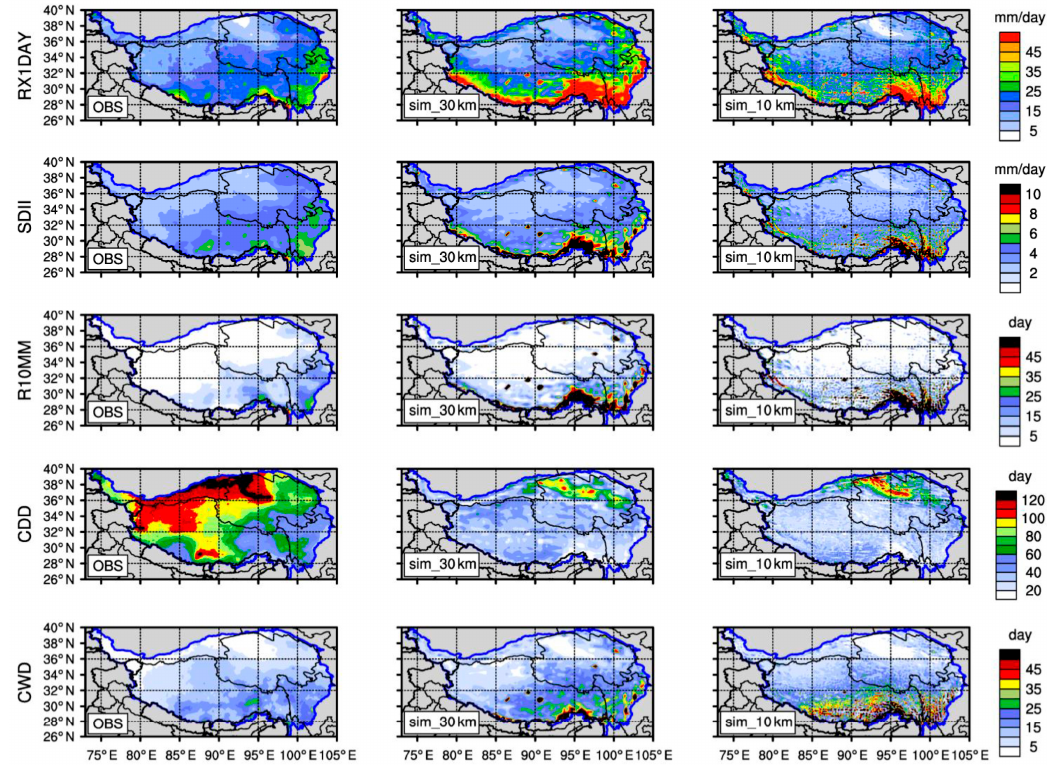
Figure 8. Spatial distribution of extreme precipitation indices based on the observation and two RegCM4 simulations over the TP (units: the former three in mm / day; the last two in day). Table 3. Observation and area averages of simulated extreme precipitation indicators for 1980 − 2010.